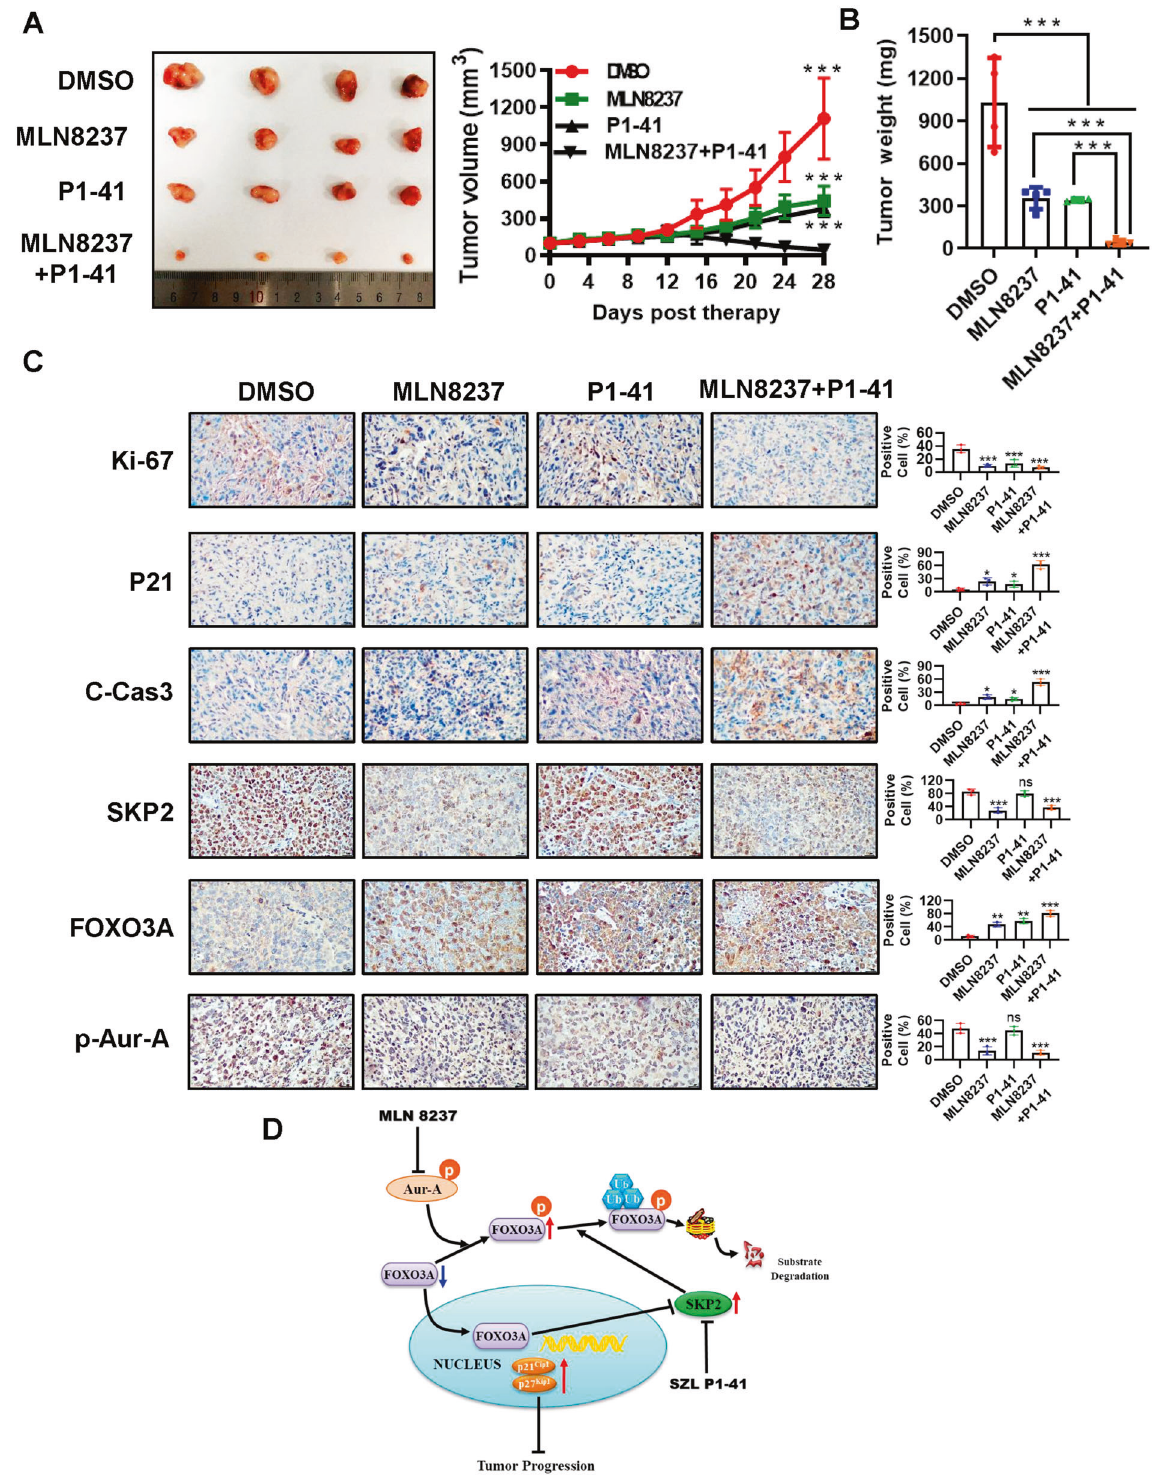
Fig. 7 MLN8237 and SZL P1-41 synergistically inhibit ccRCC tumor growth in vivo. A , B Synergistic antitumor activity of MLN8237 and SZL P1-41 in the 769-P xenograft model. 769-P ccRCC cells were injected subcutaneously into right fl ank side of nude mice. The nude mice were randomized when the tumor size reached 100 mm 3 and were treated as follows: DMSO, n = 4; MLN8237 (40 mg/kg/day of every day for 4 weeks), n = 4; SZL P1-41 (80 mg/kg/day of every day for 4 weeks), n = 4; MLN8237 + rapamycin, n = 4. The tumors were harvested and tumor growth was monitored ( A ), and tumor weight was measured ( B ). C Immunohistochemical staining of xenograft tumor tissues. Tumor tissues from four groups of nude mice were fi xed, sectioned, and stained with indicated antibodies. Scale bars: 20 μ m. D Schematic model depicting the mechanisms of action underlying Aur-A/FOXO3A/SKP2 axis promoted ccRCC cell progression and the combination of Aur-A inhibitor MLN8237 and SKP2 inhibitor SZL P1-41 showed a synergistic lethality. ns no signi fi cance; * p < 0.05, ** p < 0.01, *** p < 0.001; n = 3 independent experiments; two-tailed unpaired Student ’ s t test or one-way ANOVA with Dunnett ’ s test. Cell Death and Disease (2022)